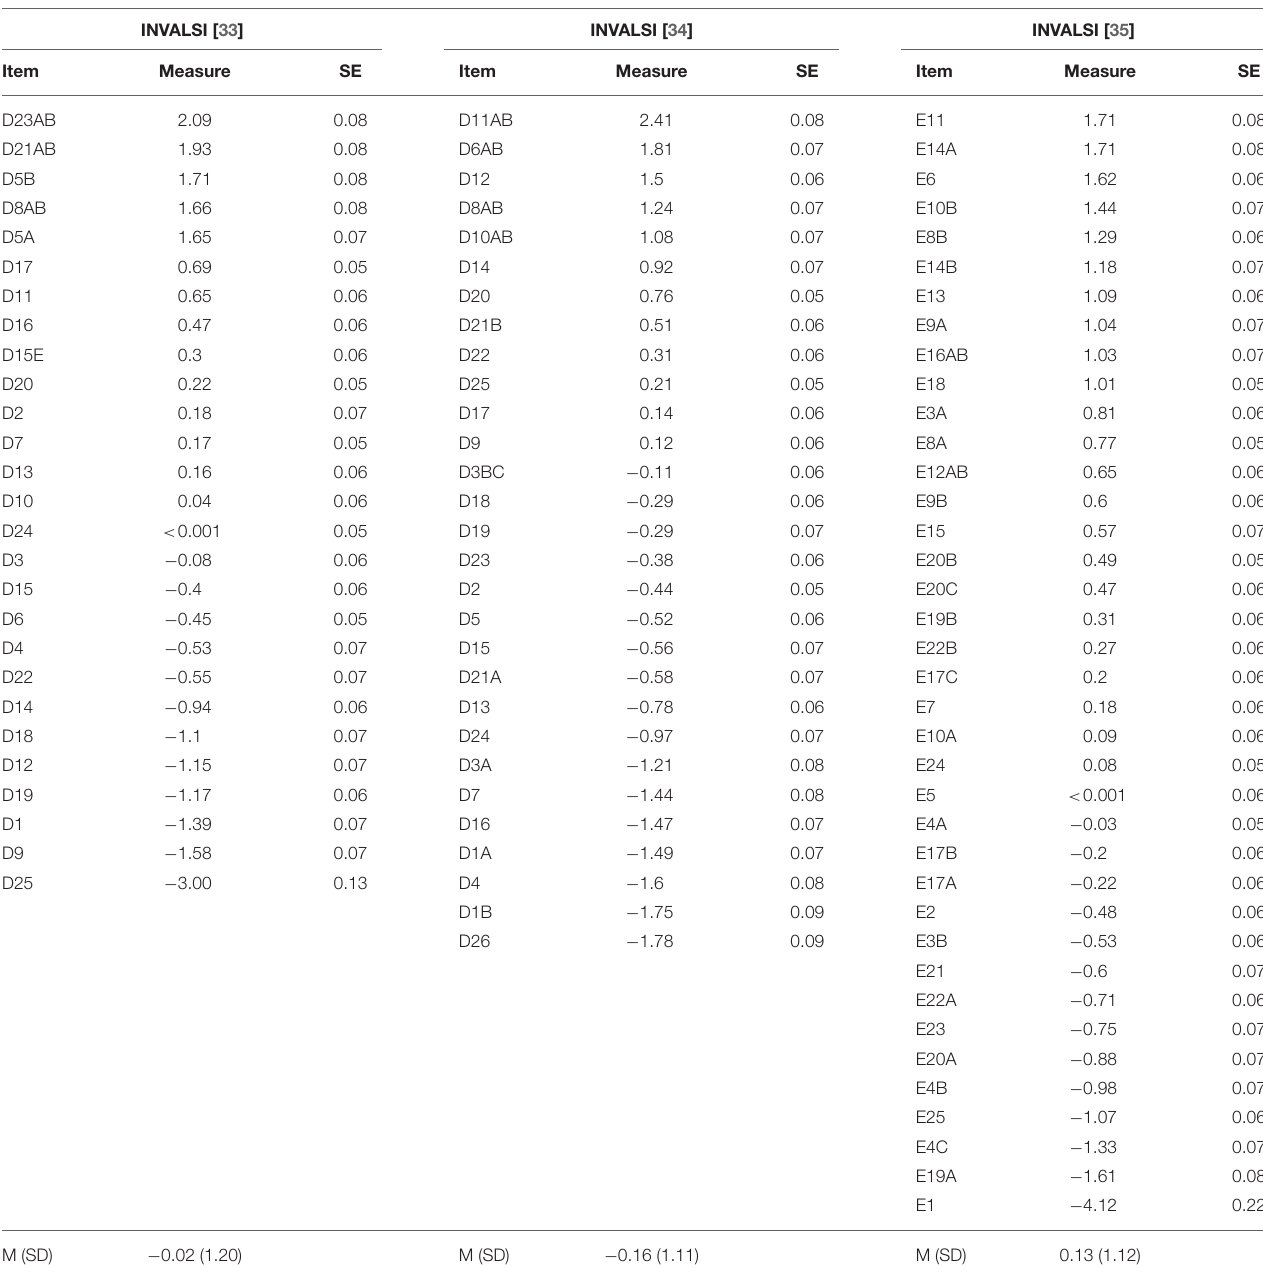
TABLE 4 | Concurrent calibration equating: item difficulty estimates for the INVALSI tests. INVALSI